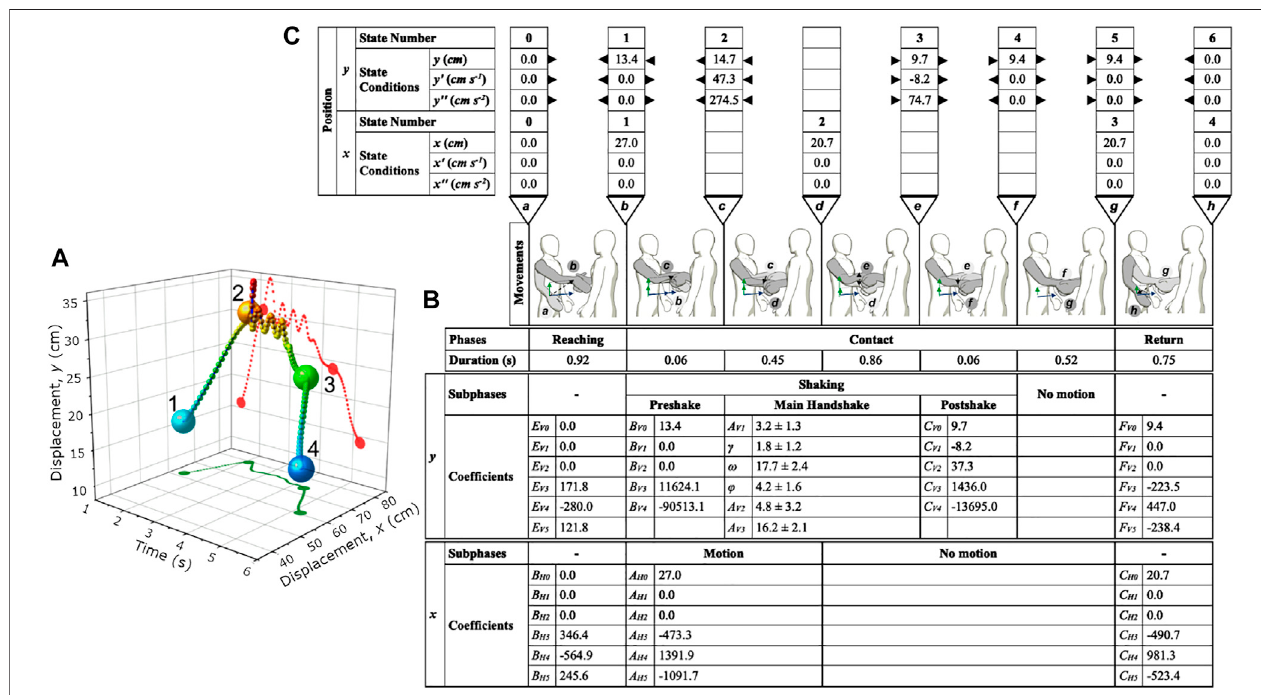
FIGURE 3 | Visualization of the position sensor at the wrist during a handshake and the modeling parameters. (A) Representative result from a single handshake trial.Thebigdots1,2,3,and4representthestartandendpointsofthethreephases:reaching,contact,andreturnphase. (B) Illustrationsofthehandshakemovements, phases, durations, and subphases. The phases and subphases of the handshake are listed together with the calculated model coef fi cients for y and x positions. The mean and standard deviation are shown only for the relevant y wrist position. (C) The states and state conditions of y and x positions, respectively, are listed and numbered. Thearrows nexttothe y -positionconditionsindicate whether the valuewas determined from thephase in-betweenthe states asanoutputor wasused asa condition for the determination of the phase model coef fi cients. For the y -coordinate position, all the state conditions originated from the main shake subphase since it wasthe fi rstverticalmotionmodeled.For x -coordinateposition,allthestateconditionswereestablishedbeforehand,sothemodelsofthephasesandsubphasescanbe determined in any order.